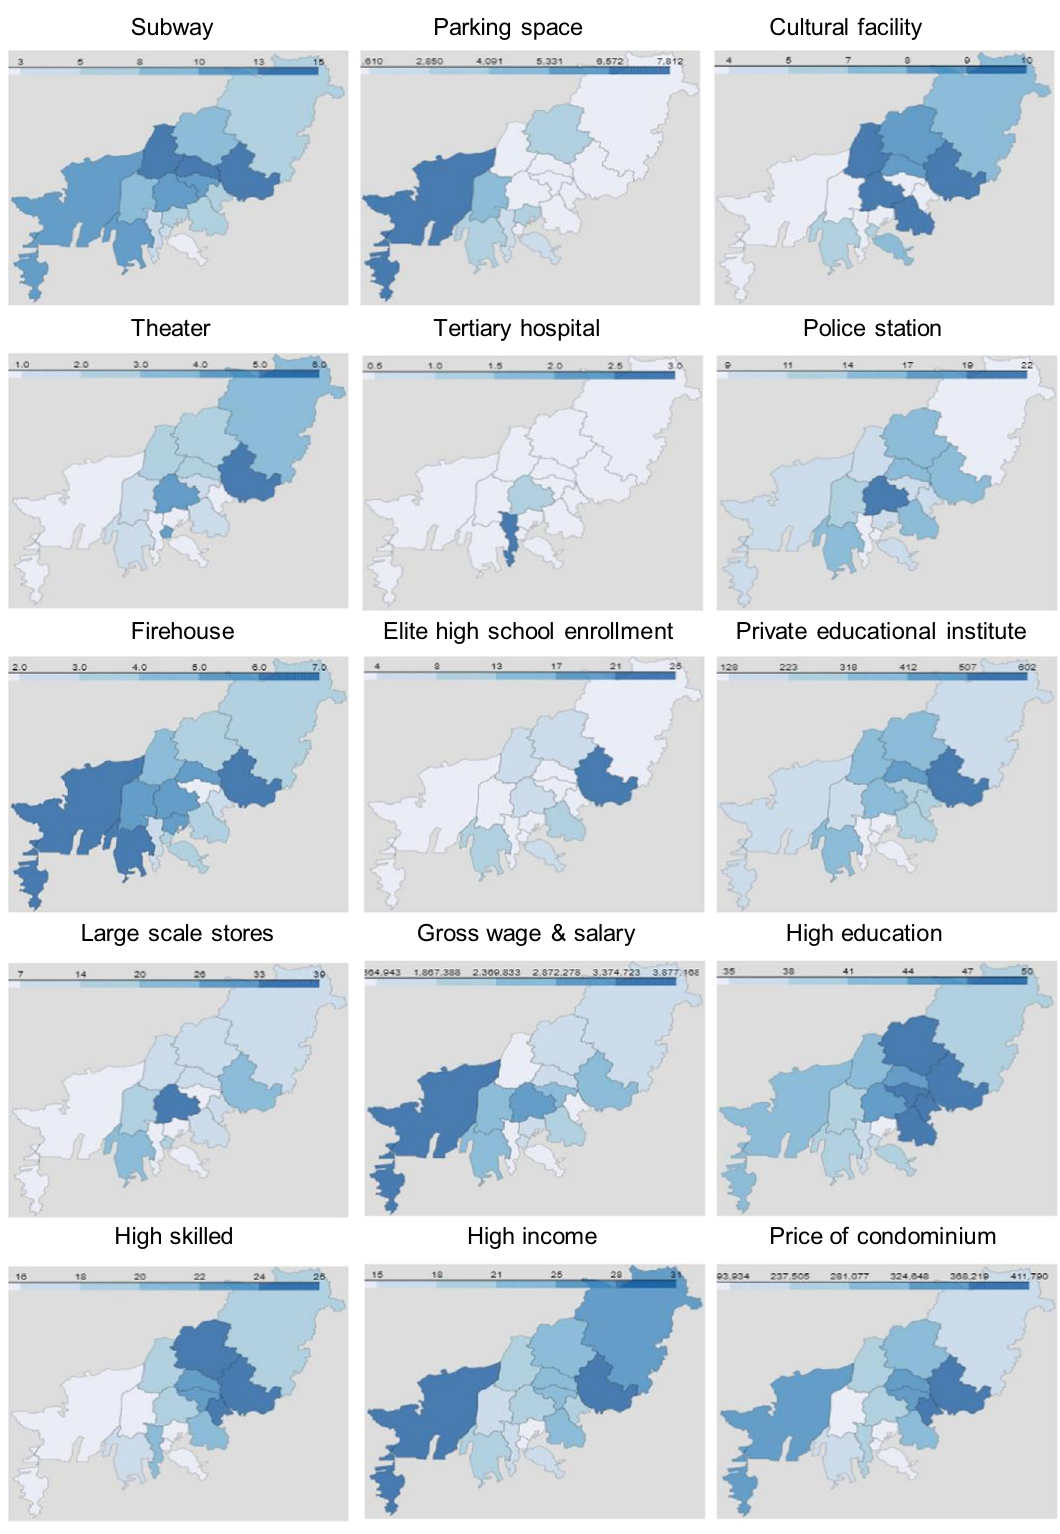
Fig. 5 Socio-spatial map of